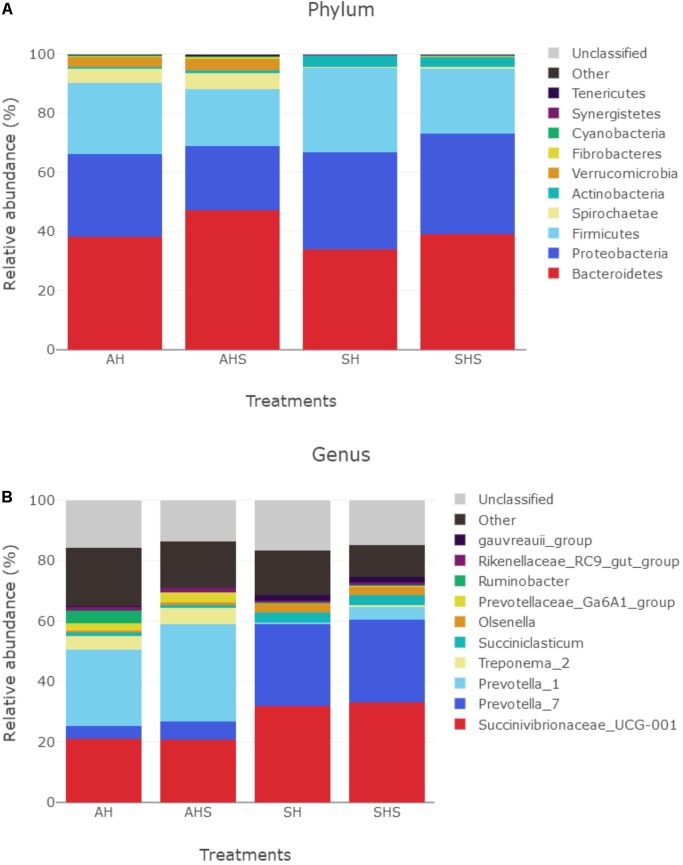
Distribution of bacterial taxa averaged under phyla (A) and genera (B) level across the dietary treatments (as a percentage of the total sequence).